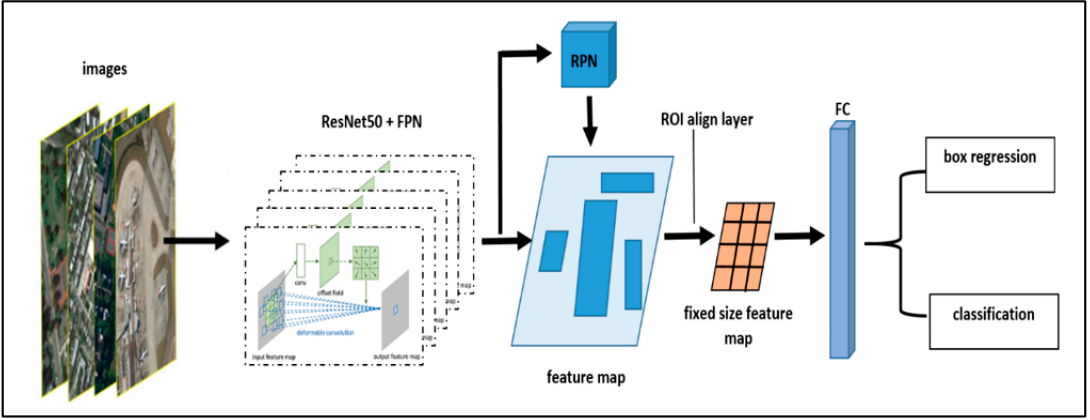
Figure 3. Network structure of the Improved Faster R-CNN .